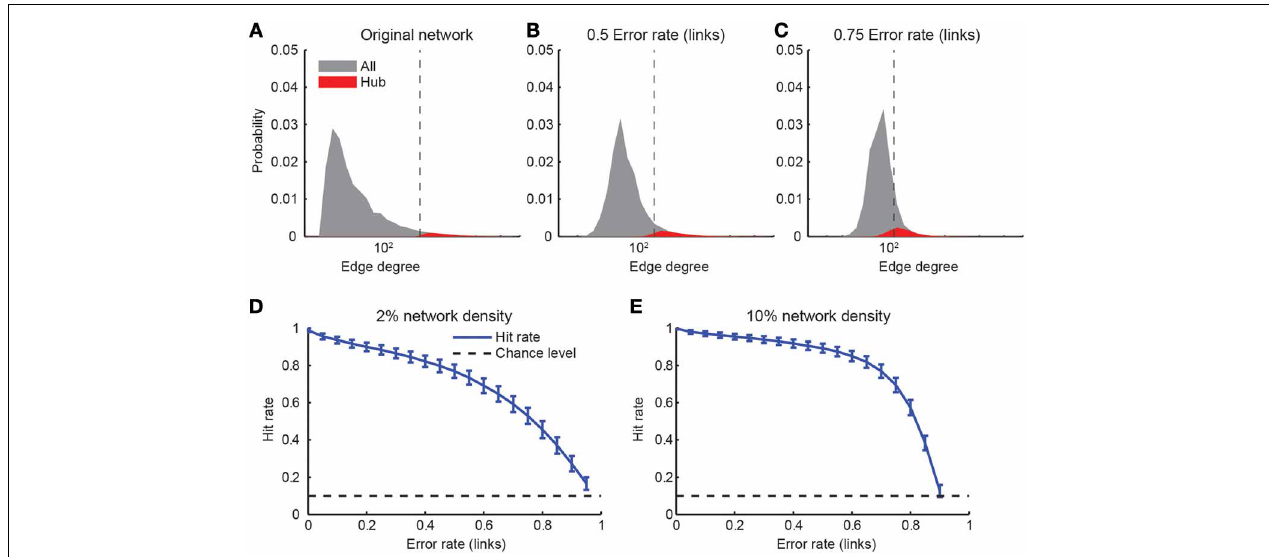
FIGURE 8 | Detection of hub neurons upon imperfect connectivity reconstruction. (A–C) Degree distributions of networks after simulated reconstructions. The degree distribution of the original network (A) followed a power law p ( x ) ∼ x − 3 above a minimal degree of 20. Hub neurons were defined as the 10% of neurons with the highest degree (red areas). Imperfectly reconstructed networks were obtained